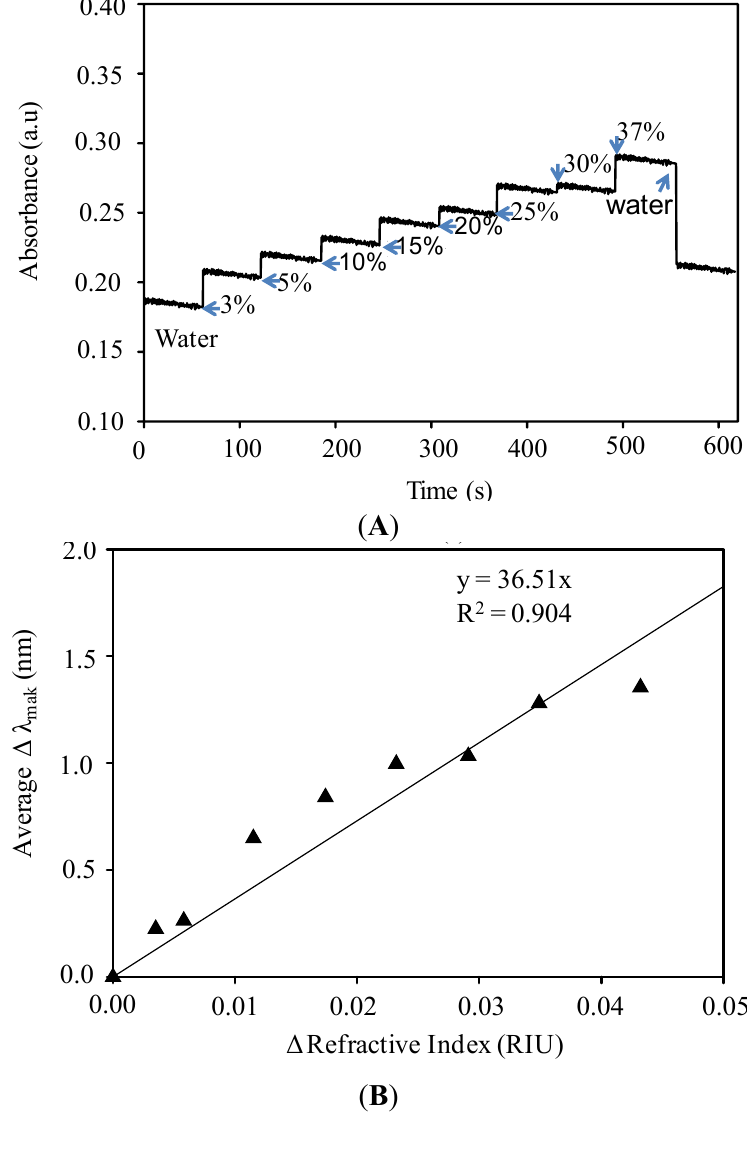
Figure 6. ( A ) Dynamic response of GNS with size of ca. 35 nm under change of FD concentrations that measured at the plasmonic peak namely 552 nm; ( B ) Plot of average plasmonic peaks shift versus medium refractive index